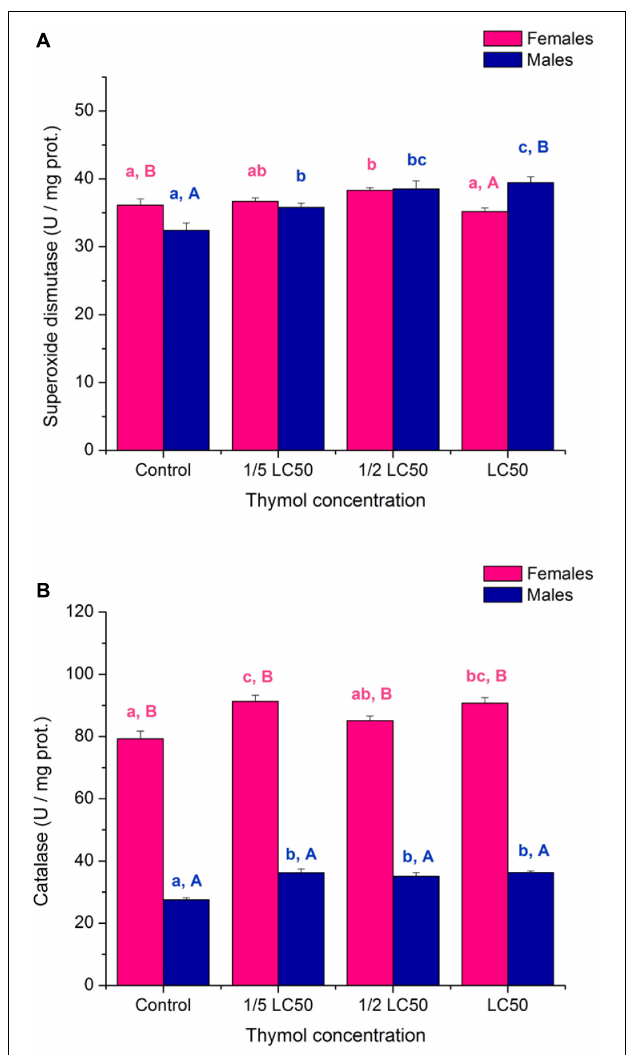
FIGURE 5 | Activity of superoxide dismutase (A) and catalase (B) in females and males of Acanthoscelides obtectus exposed to different thymol concentrations (mean ± SE for 5 replicates). Different lowercase letters (a, b, c) mark significant differences among concentrations within each sex (Duncan’s post-hoc test, p < 0.05), whereas different uppercase letters (A, B) show significant differences between females and males within each thymol concentration (LSM contrasts, p < 0.01).